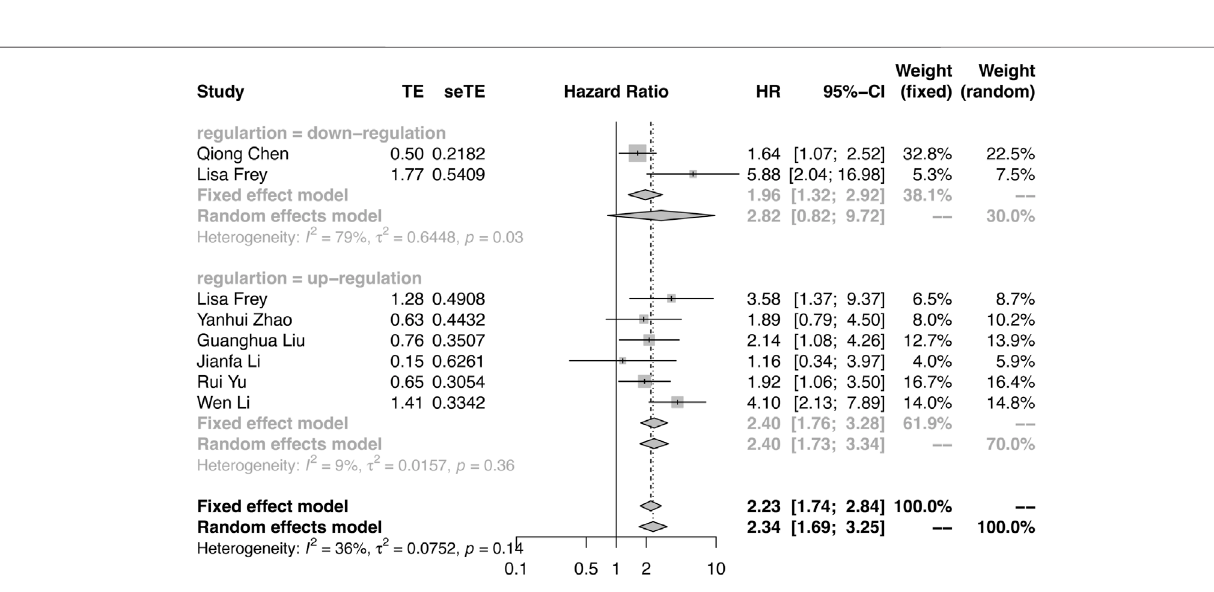
Frontiers in Genetics |